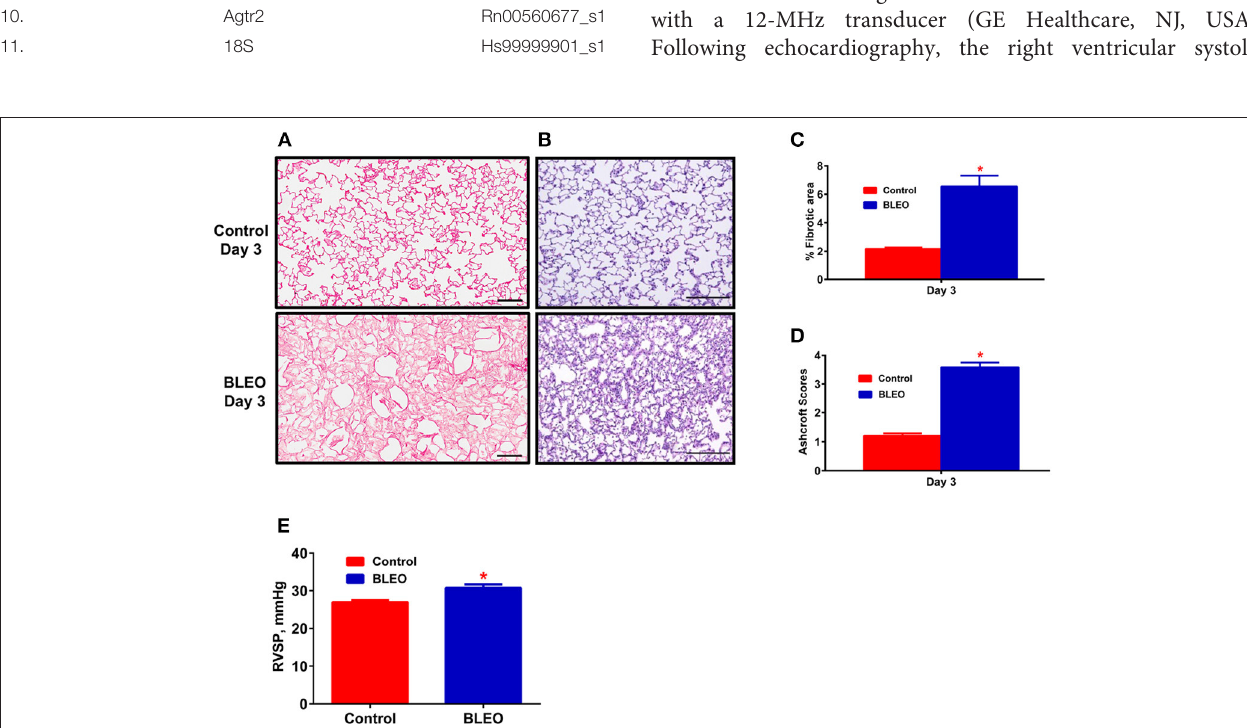
FIGURE 1 | Early onset of lung tissue remodeling and pulmonary hypertension in BLEO animals. (A,B) Representative images demonstrating picro-sirius and hematoxylin-eosin staining. (C,D) Summary data showing the lung tissue remodeling and fibrosis. (E) Summary data showing RVSP after 3 days of BLEO instillation. The data presented in (C–E) are mean ± SEM ( n = 4). *Represents a p -value of ≤ 0.05 when comparing BLEO animals against the controls. (A) Scale bar = 100 µ m and (B) Scale bar = 200 µ m.